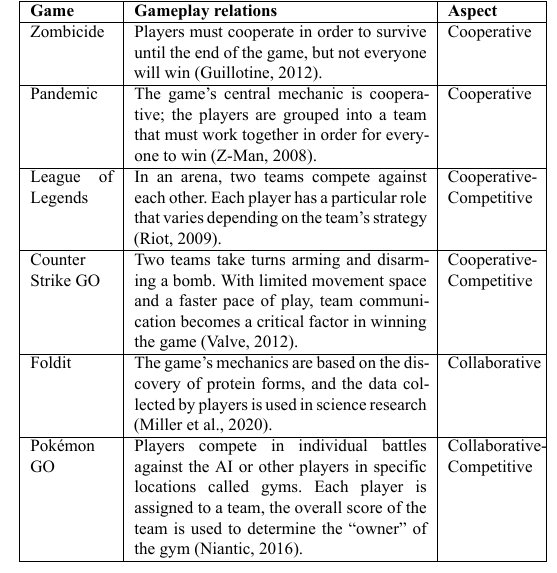
Table 2. Aspects of collaboration vs cooperation in popular digital